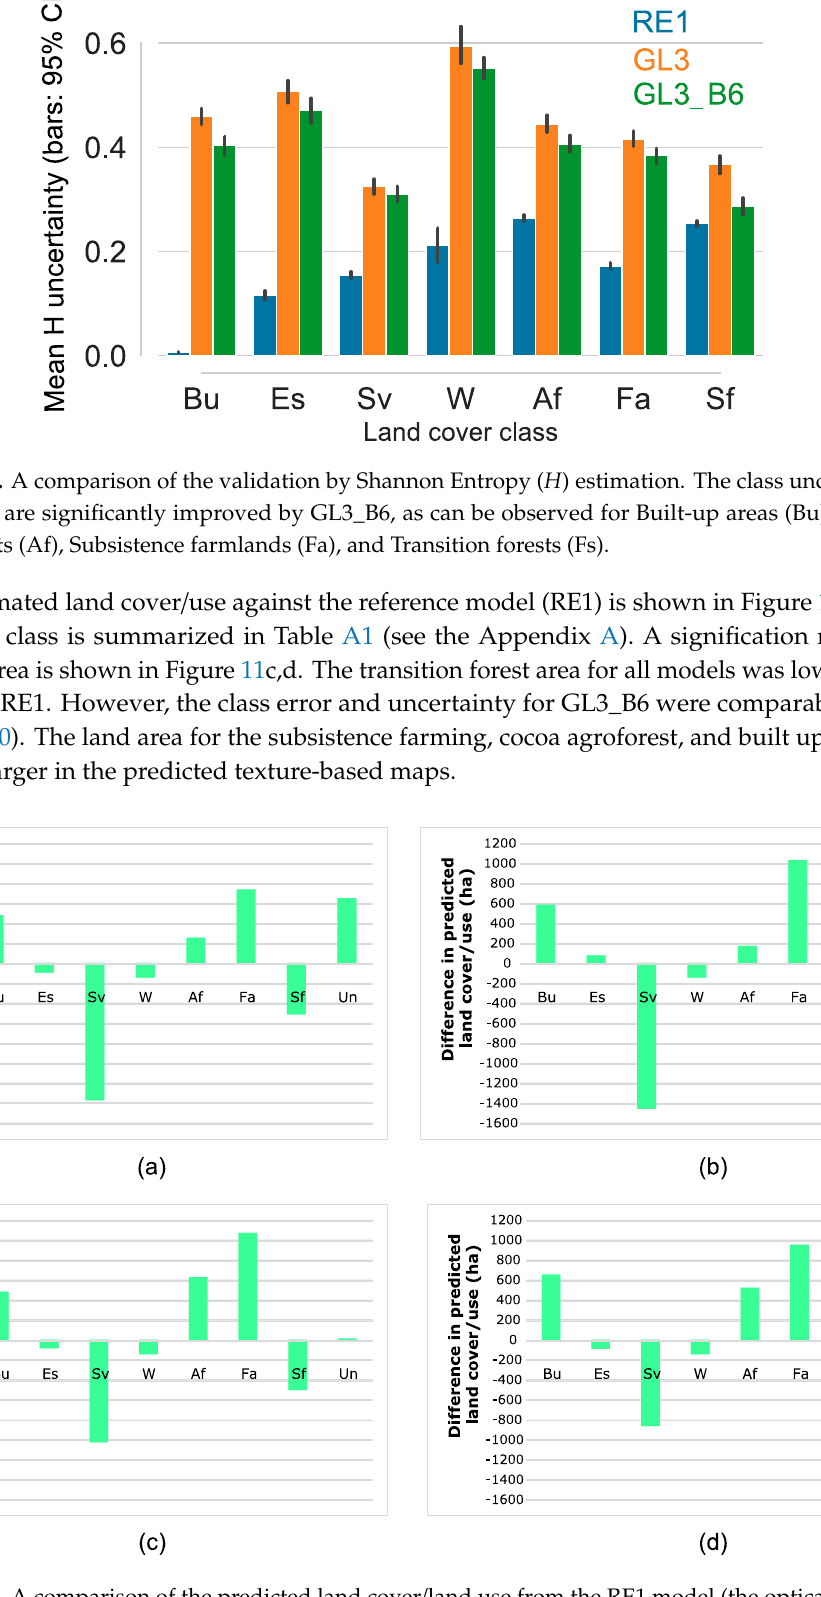
Figure 11. A comparison of the predicted land cover/land use from the RE1 model (the optical image) in the landscape with a surface area of 11,344.61 ha, with: ( a ) GL3; ( b ) GL3_B8; ( c ) GLC_B6; and ( d ) GL3_B4. See Table A1 for details.